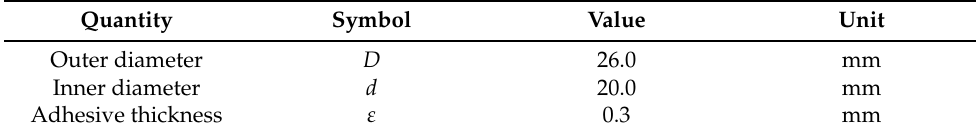
Table 1. Geometrical parameters of the joint specimen [9].